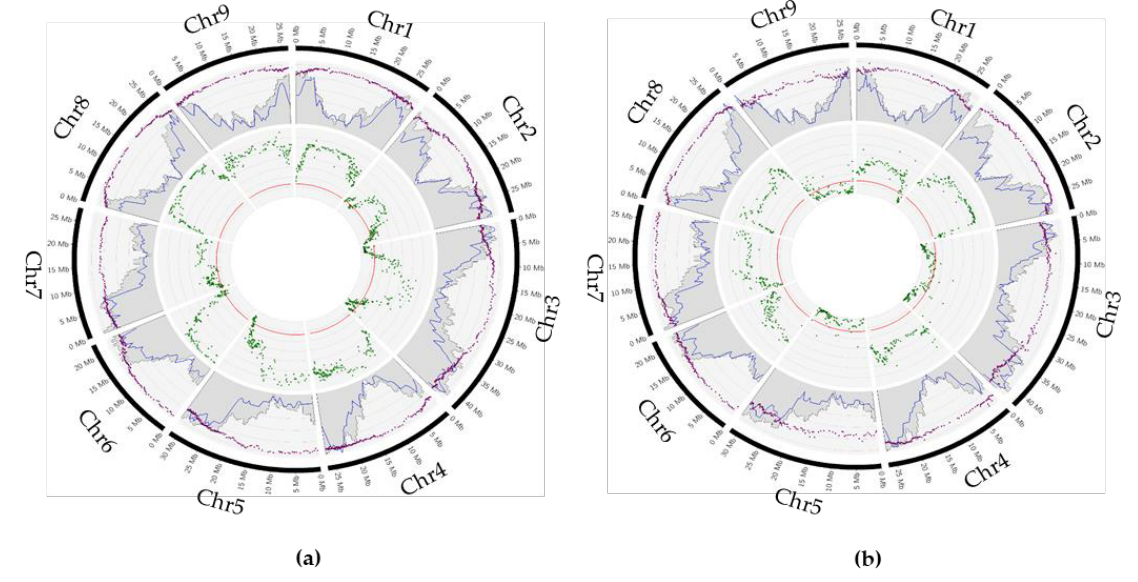
Figure 3. Circos plot of meiotic parameter in ( a ) Swingle citrumelo and ( b ) Volkamer lemon gametes along the nine chromosomes. In the first section: violet dots in the scatter plot represent the Parental Heterozygosity Restitution; grey histograms represent the gene sequence density in the P. trifoliata reference genome (Peng et al. 2020; [58]), and the blue lines represent the marker density. In the inter section: green dots represent the q-value for the deviation to the tetrasomic gametic segregation model and the red lines represent the limit of significant value.